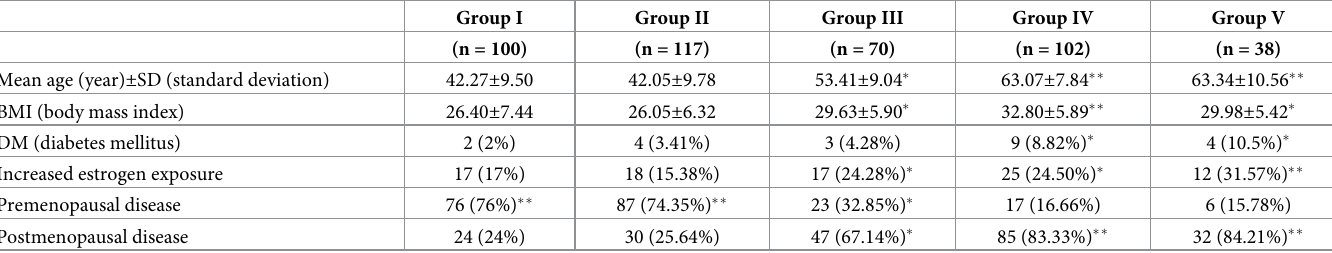
Table 1. Demographics and risk factors.